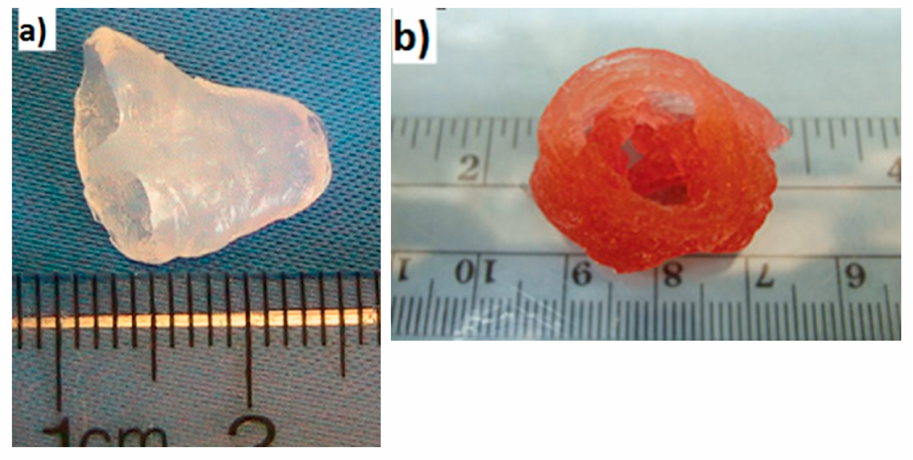
Figure 16. ( a ): Cardiac tissue by Xu et al. [132]. ( b ): Printed valve network by Duan et al.